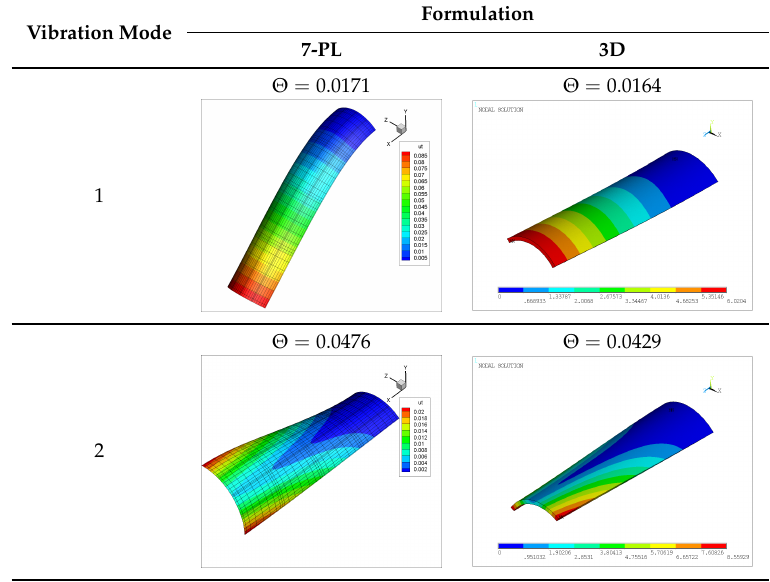
Table 22. Vibration modes for a cantilevered quarter of cylinder with linear thickness variation, L / r =